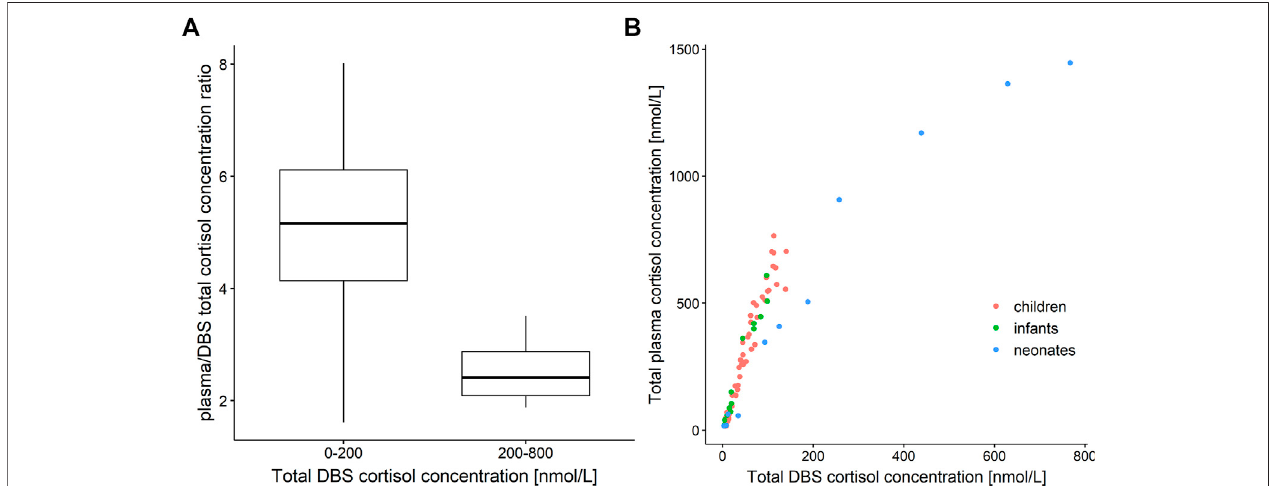
FIGURE 1 | (A) Boxplot of plasma/dried blood spot (DBS) cortisol concentration ratio versus cortisol DBS concentration ranges of 0 – 200 nmol/L ( n = 83) and 200 – 800 nmol/L ( n = 4). (B) Total cortisol concentration in plasma versus total cortisol concentration in dried blood spots (DBS). Red: children, green: infants, blue: neonates.